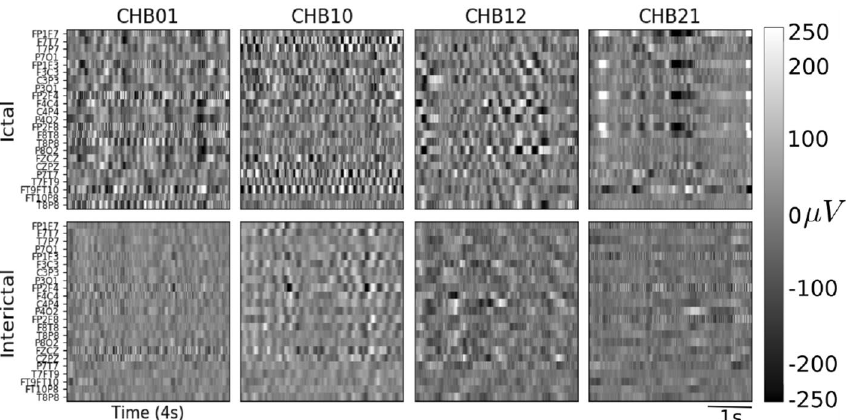
Figure 10. Examples of the signal representation taking the amplitude as the pixel attribute for four patients from the CHB-MIT Scalp dataset. The height encodes the channels in bipolar configuration, and the width the window length (4 s) with the aspect ratio adjusted for visualization purpose. The colorbar displays the amplitude range of the signals in µ V. Top row: ictal examples, bottom row: interictal